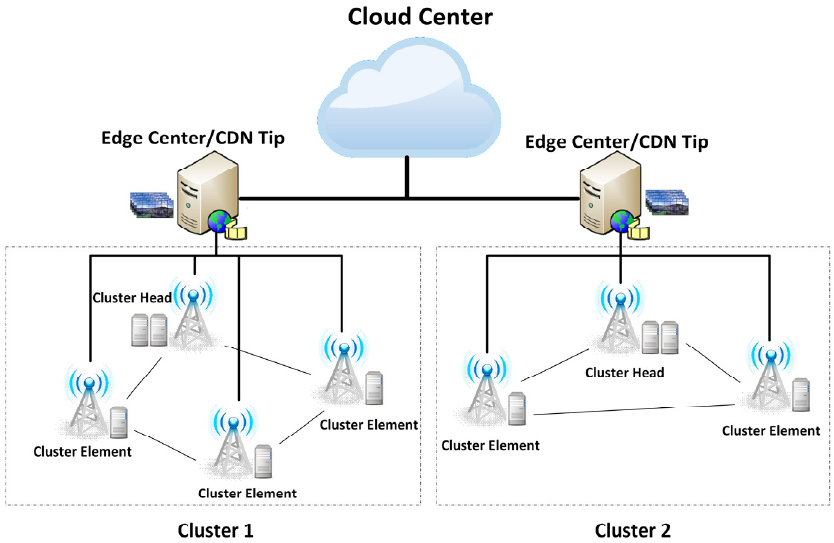
Figure 1. Hierarchical Clustered Mobile Edge Computing (HC-MEC) networks. (a) Vertical layering: In this network, the VR panoramic video transmission model is seamlessly connected with the current general video transmission CDN technology. Ver-